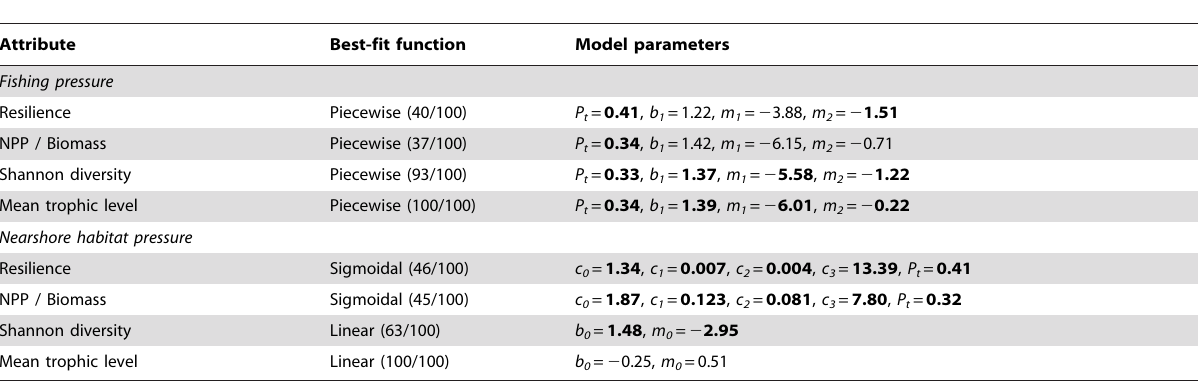
Table 2. Best-fit models and parameters for attribute–pressure relationships generated through fishing pressure ( n = 15) and nearshore habitat pressure ( n =14) Monte Carlo simulations ( n = 100 at each pressure level).